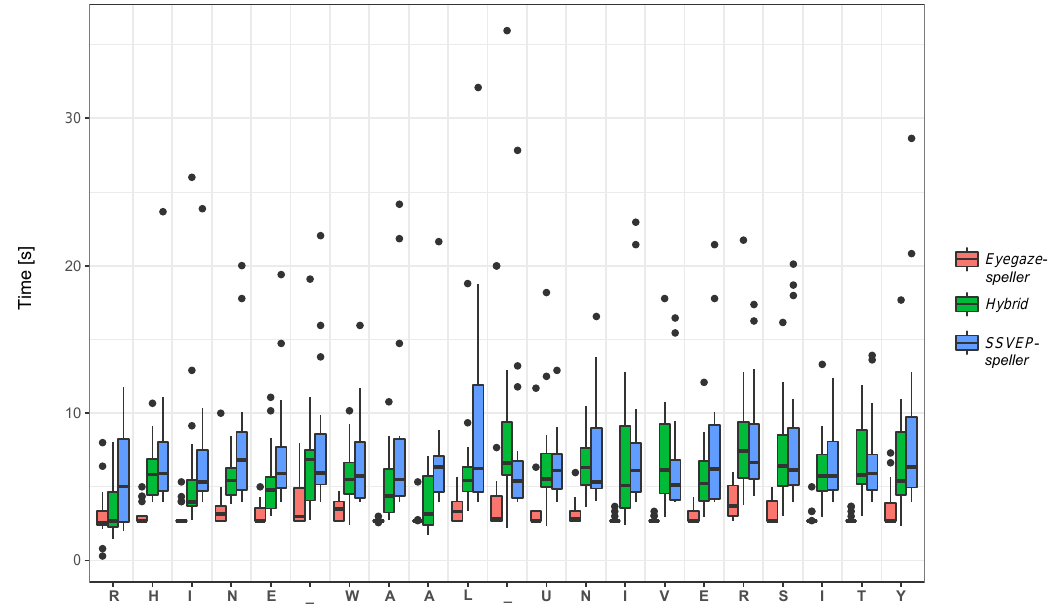
Figure 6. Comparison of letter selection times (only correct selections, i.e., last selection in case of corrected spelling errors). The average classification time needed for every letter of the spelling phrase is provided for each of the tested systems: the steady-state visual evoked potentials based application ( SSVEP speller ), the here presented Hybrid application, and the eye tracking based application ( Eyegaze speller